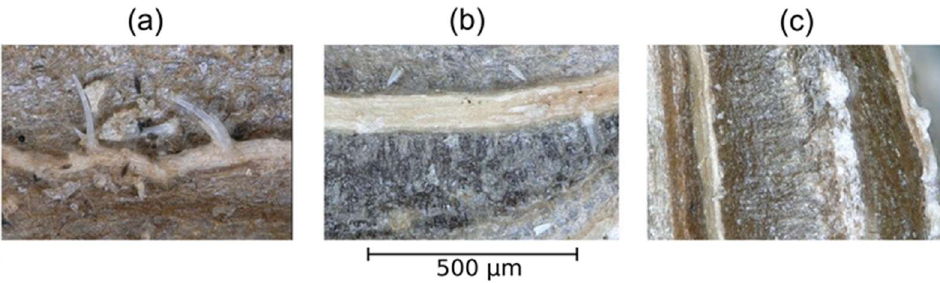
Figure 8. Optical microscope images of Daucus carota at 500× magnification. ( a ) Control (water); ( b ) PAW 5′; ( c ) PAW 20′.